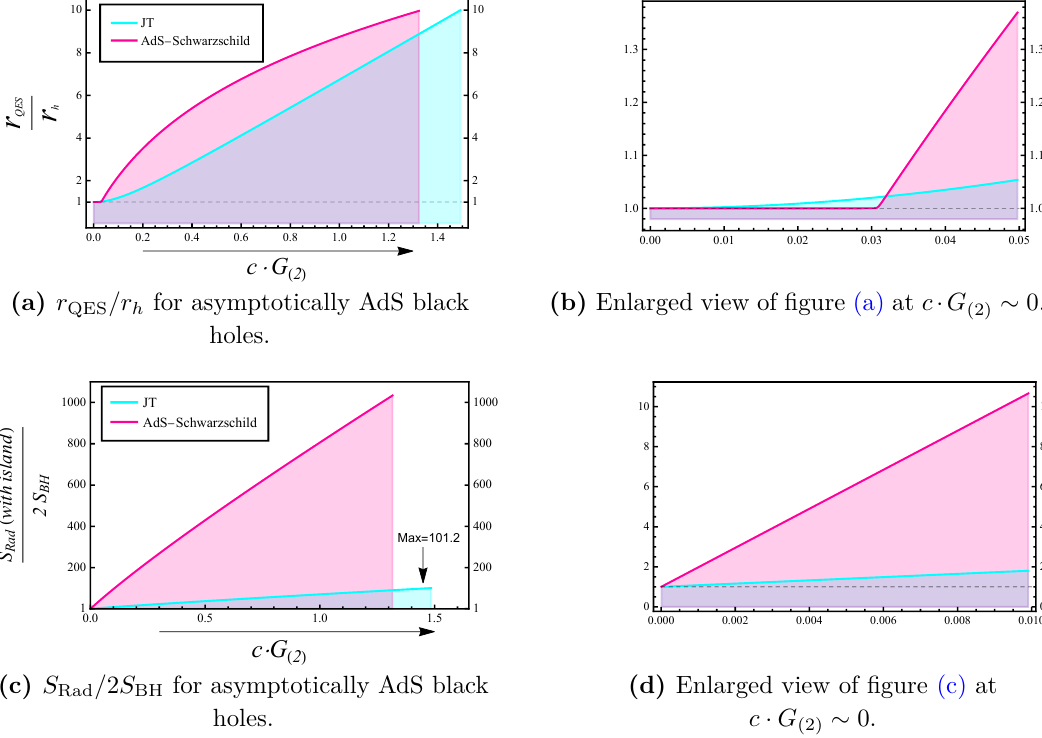
(b) Enlarged view of figure (a) at c · G